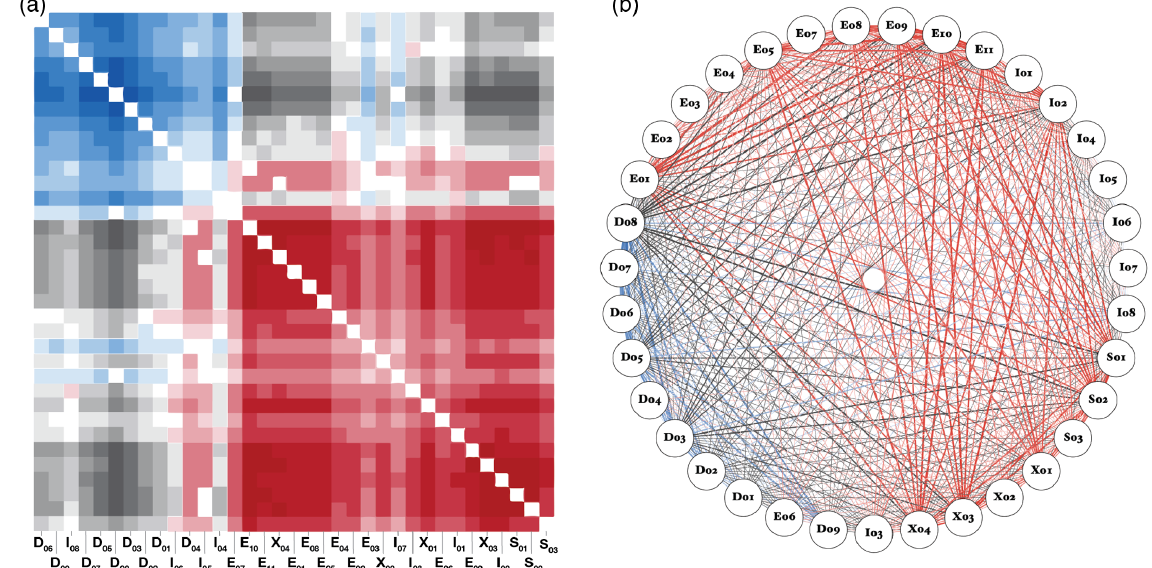
FIG. 2. Representations of the full network of ASES items. (a) Adjacency matrix of ASES items represented by a heat map. (b) Network of survey items arranged in a circle with edge weights corresponding to the absolute value of the similarity. Both the adjacency matrix representation and the network representation use two scales: one for items that share similar responses that ranges from red (mutual agreement) to blue (mutual disagreement), the second for items that share dissimilar responses ranging from black (most dissimilar) to white (no correlation in